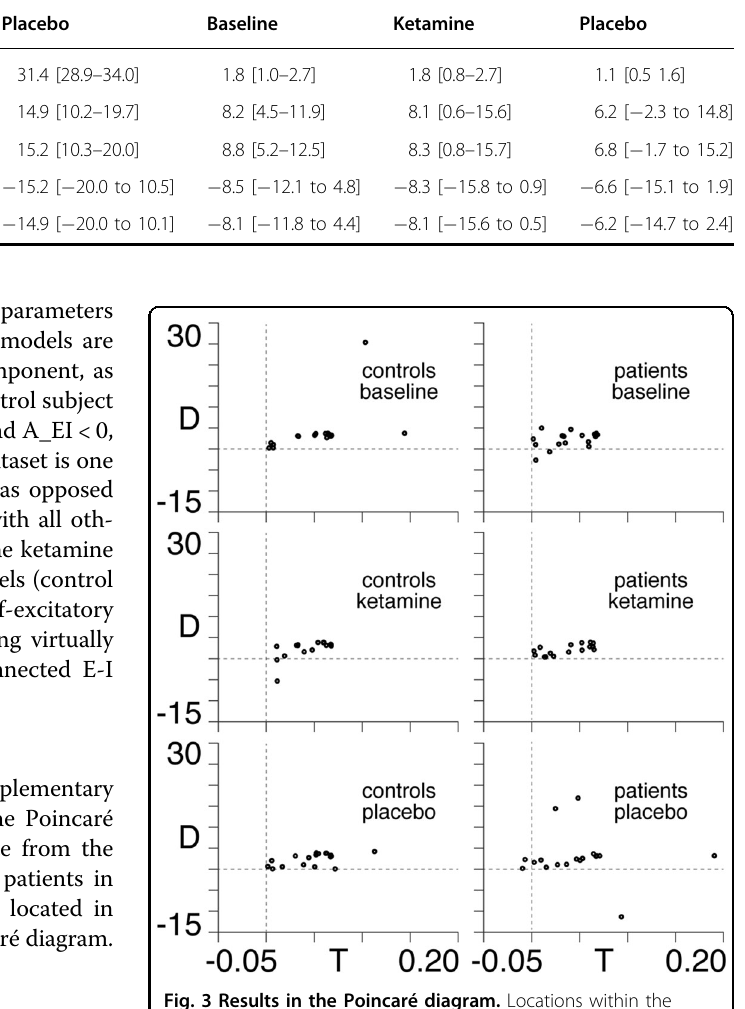
Fig. 3 Results in the Poincaré diagram. Locations within the Poincaré diagram plotted for all controls (left column) and patients (right column) under baseline ( fi rst row), ketamine (middle row) and placebo (last row) conditions. The faint dotted lines show the axes of the trace (T) – determinant (D) plane within the Poincaré diagram.